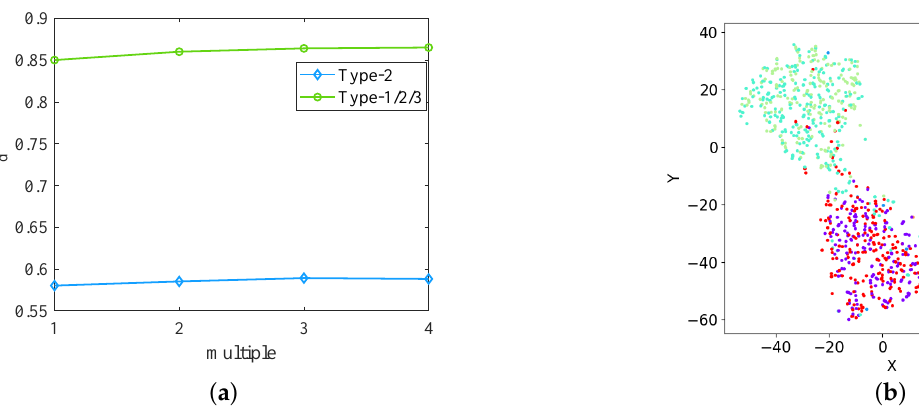
Figure 15. When the number of components of Gaussian mixture c changes in a multiple: ( a ) when SNR = 11 dB, the detection performance curves in single clutter and complex clutter scenes; ( b ) when SNR = 11 dB, considering complex clutter scene, the number of components of c is 6 (multiple is 2), the visualization results of the z -space at this